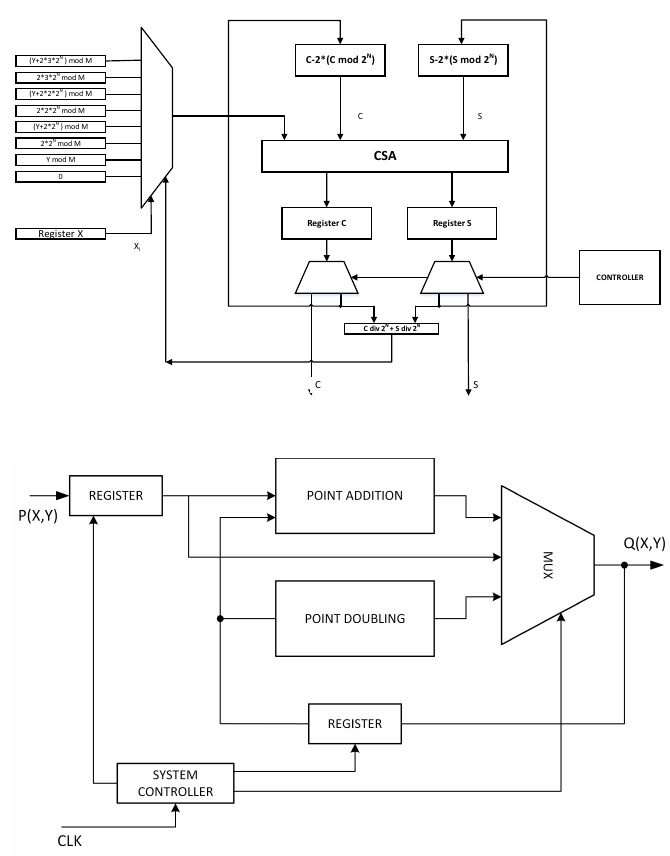
Figure 1. Interleaved Modular Multiplier (top) and ECC core Diagram